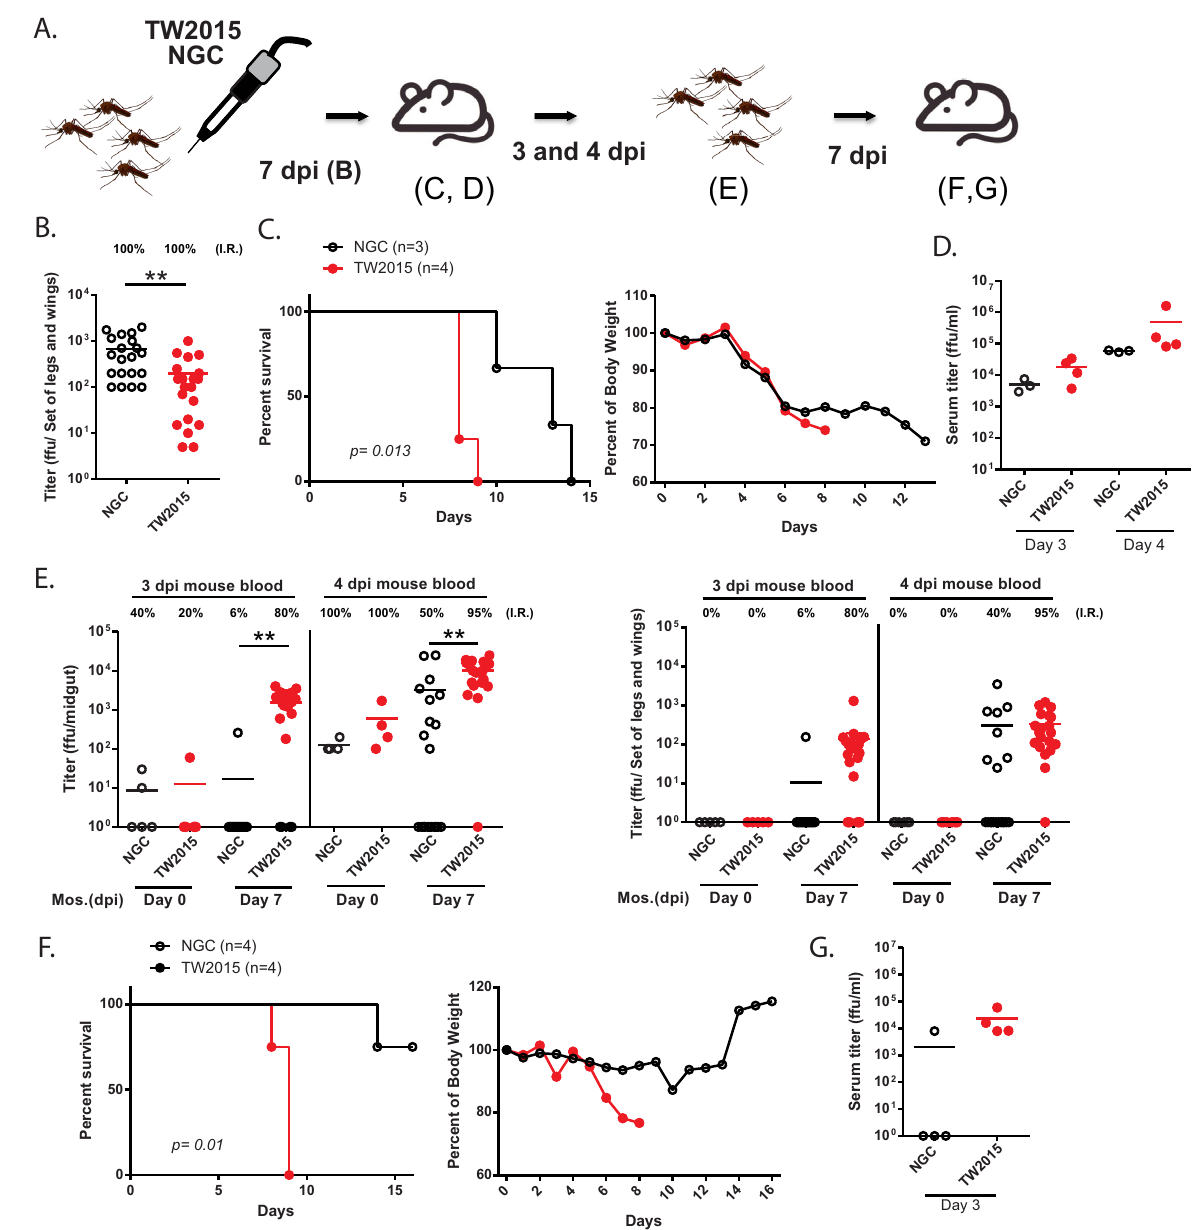
Fig 4. The TW2015 virus was transmitted in a mosquitoes-mouse-mosquitoes-mouse cycle. (A) Experimental model of a complete transmission cycle. (B) Viral titer in legs and wings of Aedes aegypti mosquitoes following infection with DENV-2 viruses (thoracic injection, 400 pfu/mosquito; 7 dpi; n = 20). (C) Survival and body weight of AGB6 mice (n = 3–4) infected with DENV-2 strains via exposure to DENV2-carrying mosquitoes (10–21 mosquitoes/mouse). (D) Mouse viremia on days 3 and 4 post-mosquito exposure. (E) Viral titers in midgut, legs, and wings of previously na ï ve mosquitoes directly following a blood meal (Day 0) from DENV-infected mice (described in C , at 3 or 4 dpi) and at 7 dpi (n = 5–20). (F) Survival and body weight of AGB6 mice exposed to 4 dpi blood-infected mosquitoes (6–9 mosquitoes/mouse; 7 dpi). (G) Mouse viremia at 3 dpi. dpi, days post-infection; mos, mosquito. � p < 0.05, �� p < 0.01. days of further incubation (i.e., mosquito dpi, Mos. dpi), 3 and 4 dpi-viremic blood from the NGC-infected mice caused infection at rates of 6% and 50% in the mosquito midgut, respec- tively. In contrast, 3 and 4 dpi-viremic blood from the TW2015-infected mice led to infection